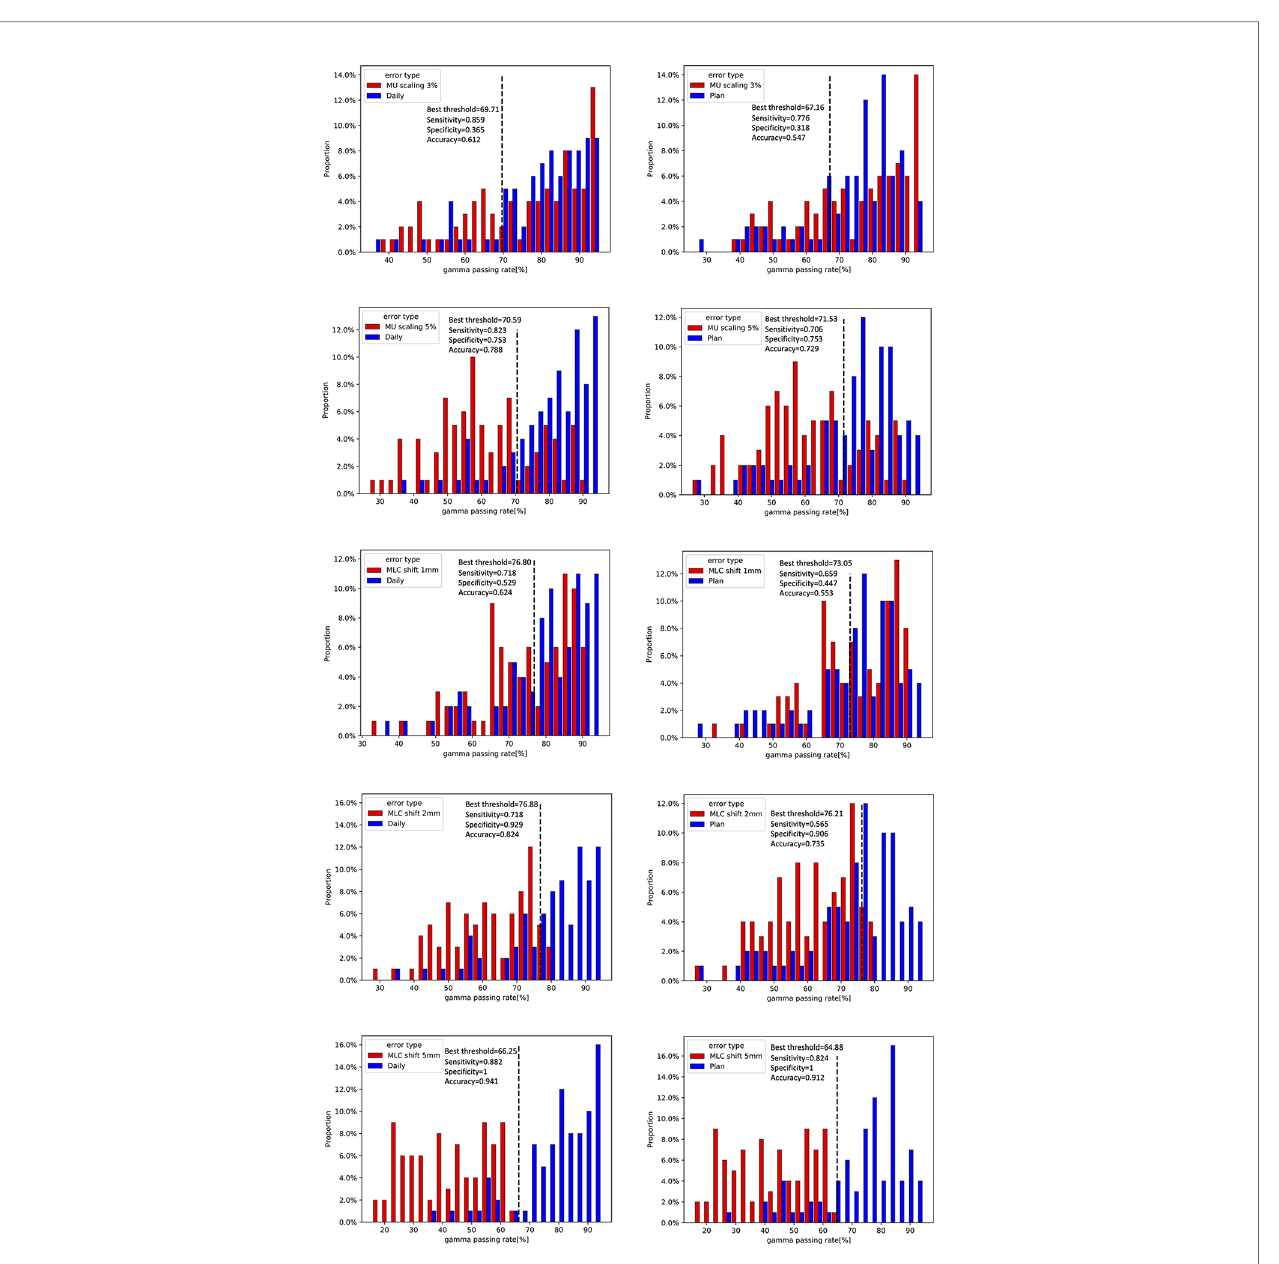
FIGURE 9 | Distribution of gamma passing rates for daily CT (dCT)-based plan and a plan with a 3% and 5% scaling in monitor units (MUs) and a 1-, 2-, and 5-mm shift in multileaf collimator (MLC) leaf (left). Dilstribution of gamma passing rates for planning CT (pCT)-based plan and a plan with a 3% and 5% scaling in MU and a 1-, 2-, and 5-mm shift in MLC leaf (right).